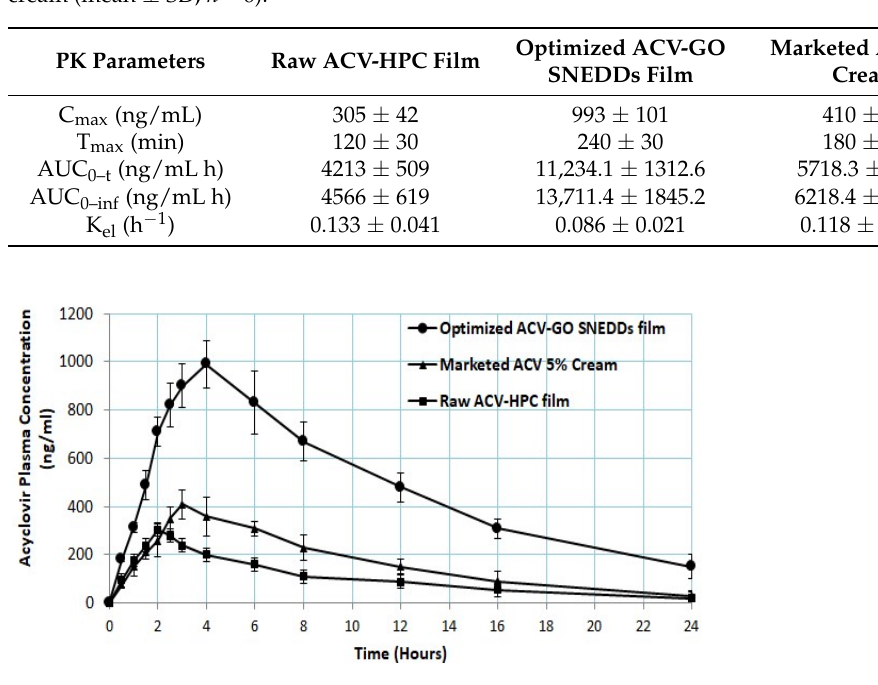
Figure 5. ACV plasma concentration (ng/mL) from optimized ACV-GO SNEDDS transdermal film; Raw ACV-hydroxyl propyl cellulose (HPC) film formulations and marketed cream (mean ± SD, n =